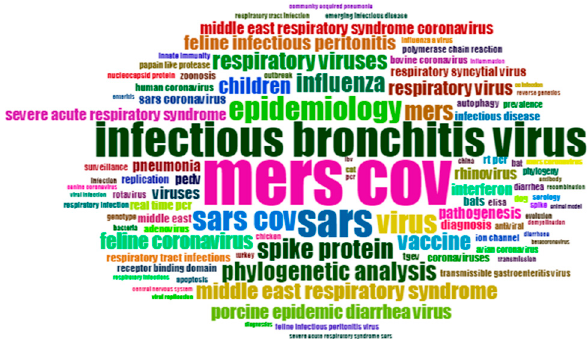
Figure 7. Keywords cloud map of 2012 – 2015. Table 7. Items and frequency of hot keywords during 2012 – 2018.